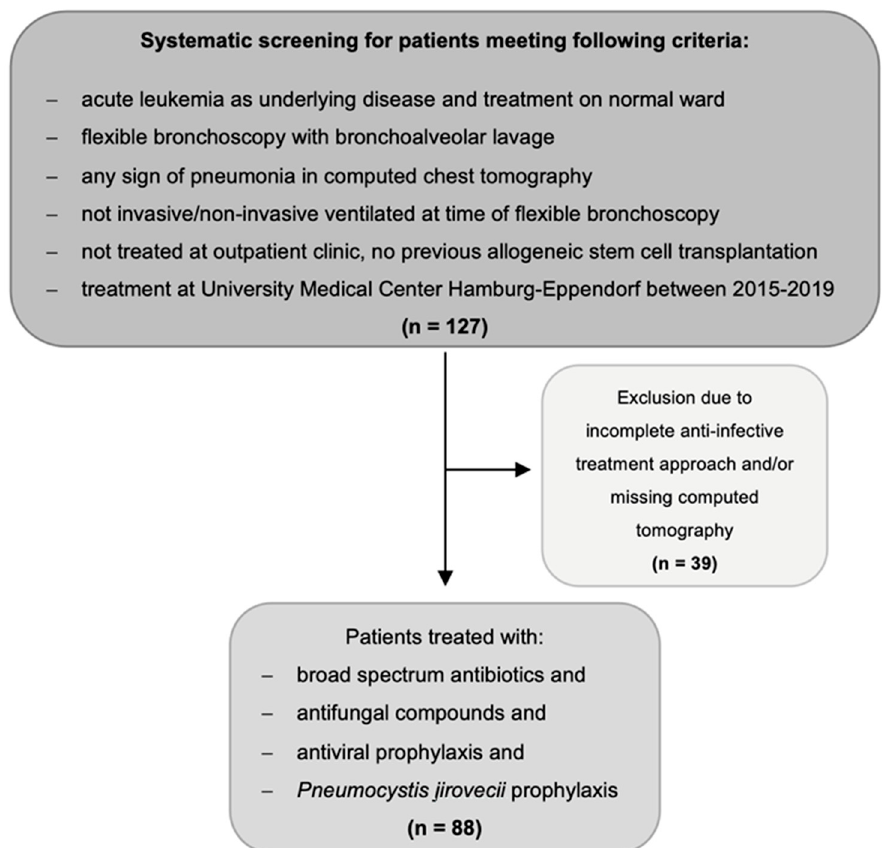
Figure 1. Flow chart of study design and population.